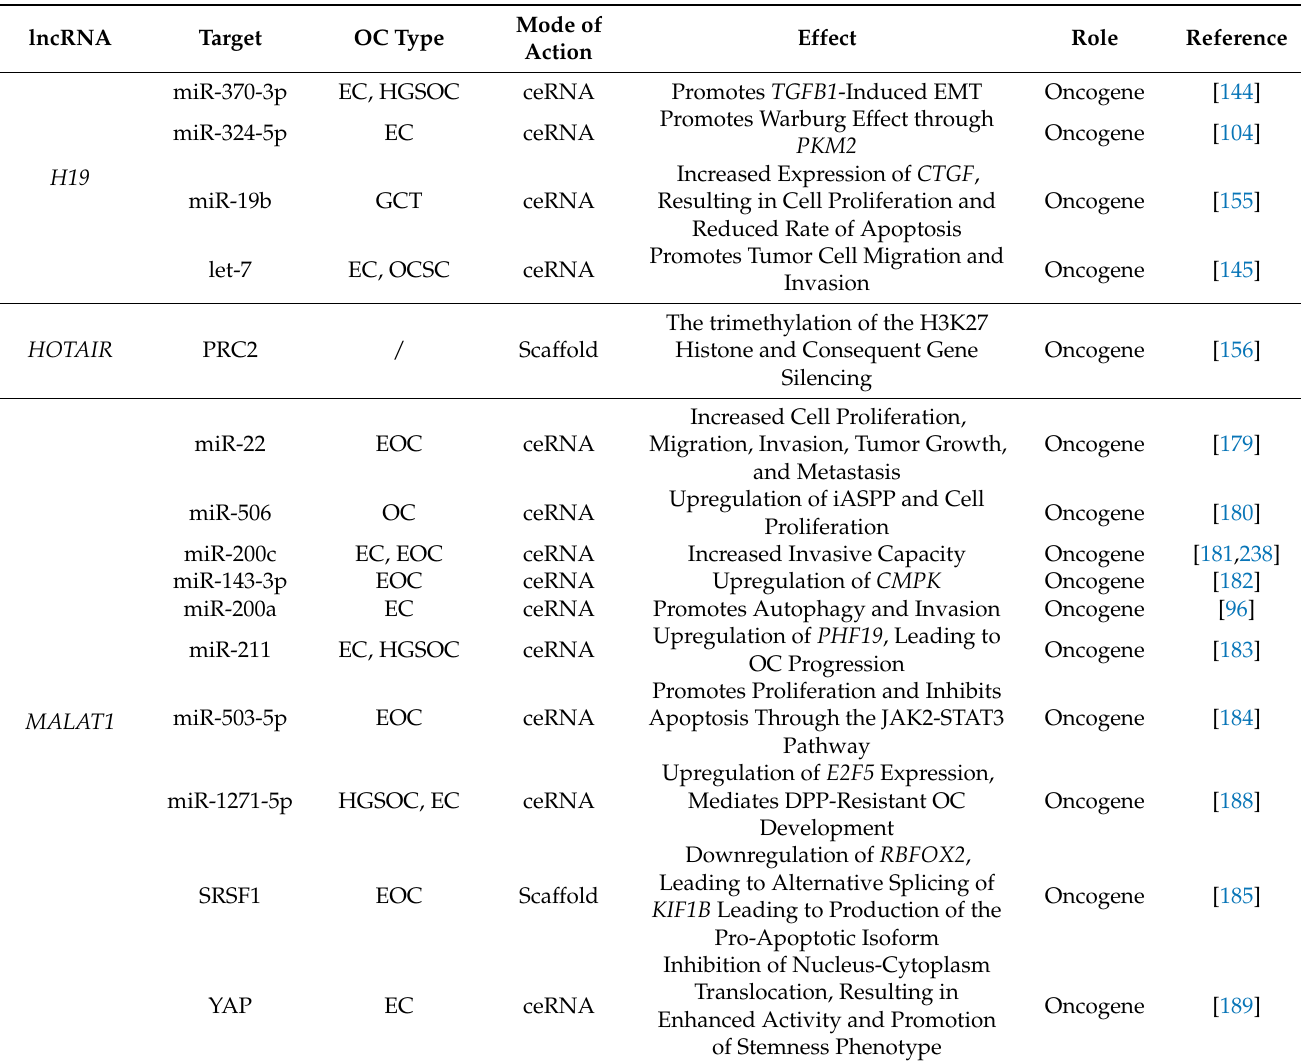
Table 2. The lncRNAs frequently involved in OCs and their mechanisms of action. OC type includes rare OC types (GCT–granulosa cell tumor) and common OC types (HGSOC–high-grade serous ovarian carcinoma, EOC–epithelial ovarian cancer, EC–endometrioid carcinoma), while the abbreviation OC refers to papers that did not define specific OC subtypes, and OCSC refers to ovarian cancer stem